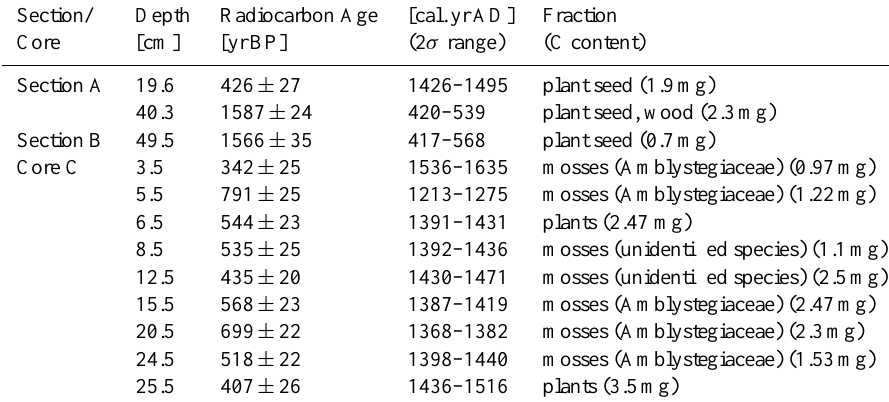
Table A1. Accelerator mass spectrometry dates from polygon 07-SA-LY.